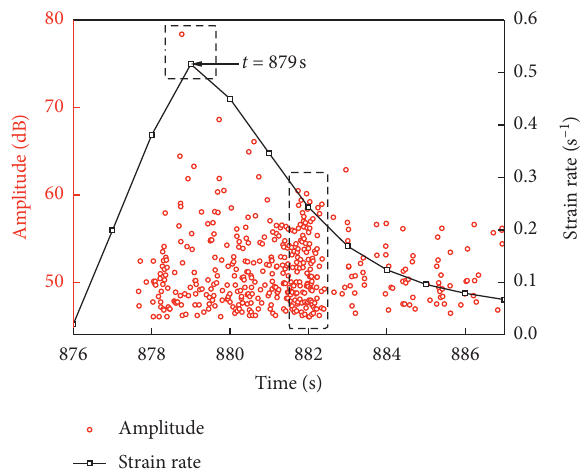
Figure 12: Amplitude and radial strain rate of unloading stage under confining stress of 30